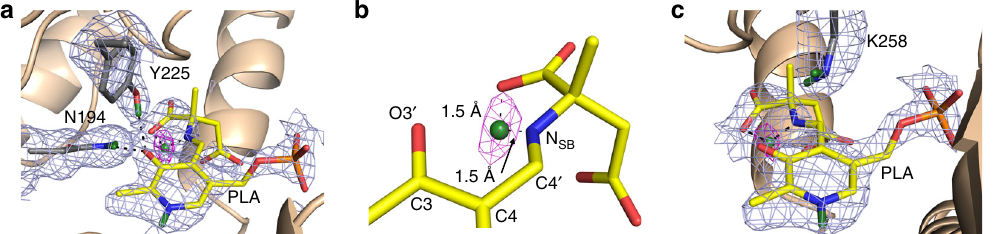
Fig. 3 Neutron structure of the external aldimine. a External aldimine state in the AAT- α -methylaspartate neutron structure. b Close-up of the D atom that is equidistant between the N SB and carboxylate oxygen. c External aldimine and the catalytic base, K258. For clarity, the omit | F o | − | F c | difference nuclear scattering map is presented for the deuterium atom on